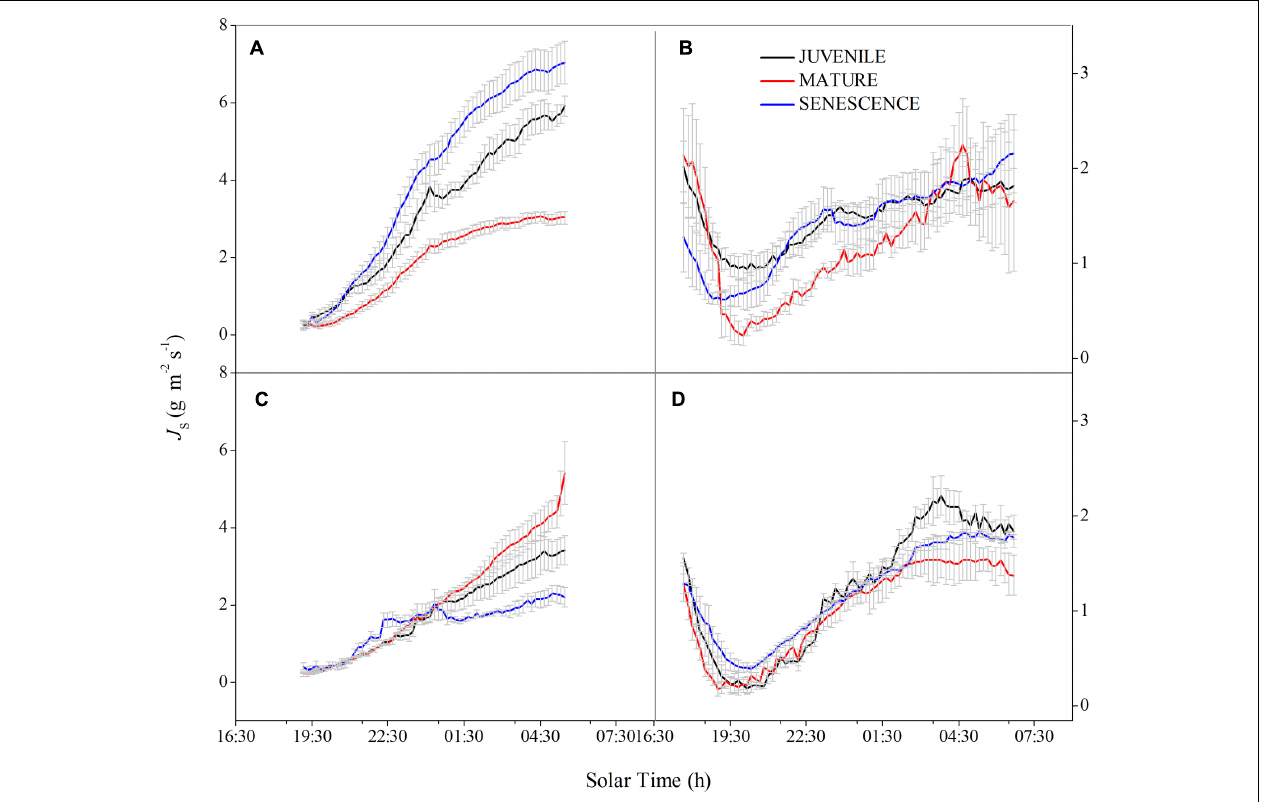
FIGURE 2 | Night-time sap flow density ( J s ) pattern. Normal bamboo in wet (A) and dry (B) . seasons; rhizome-cut bamboo in the wet (C) and dry (D) seasons. The same day was chosen to describe the pattern as Figure 1 .